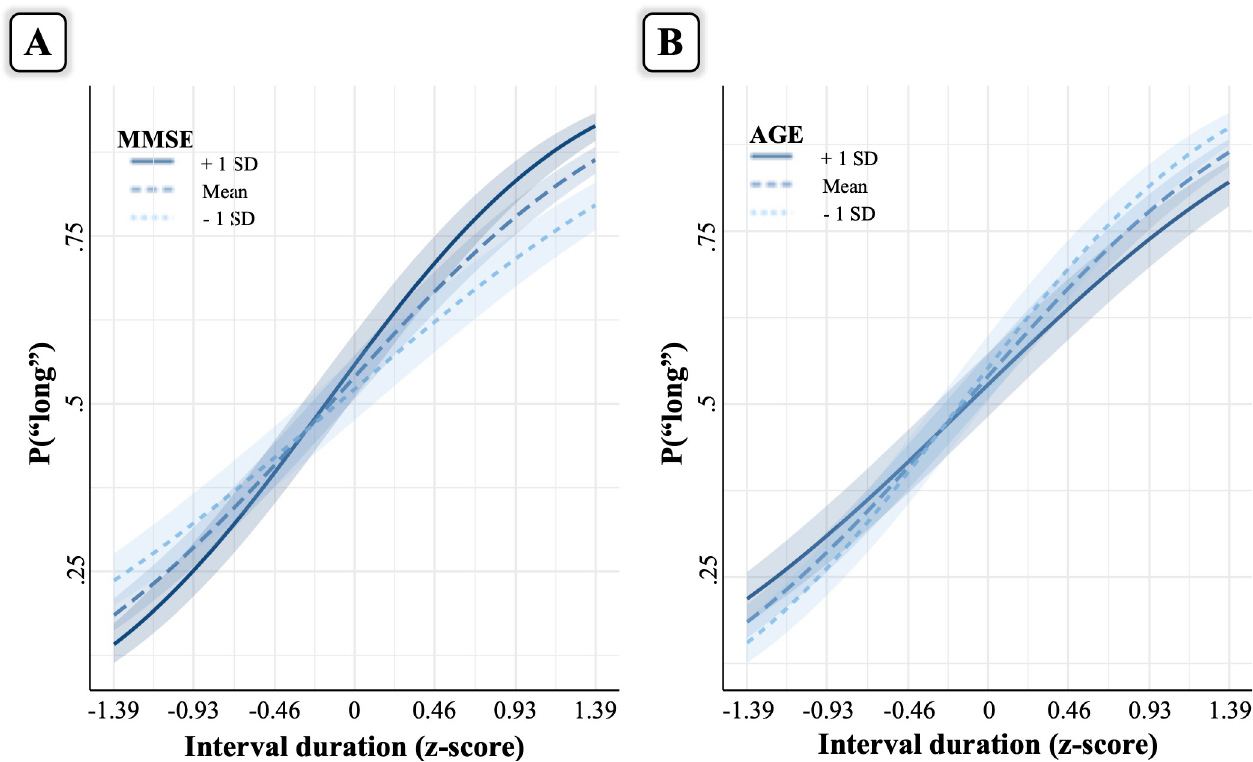
Fig 3. Interaction effects in the explicit timing task. Panel A depicts the interaction between Interval duration and MMSE, whereas panel B depicts the interaction between Interval duration and Age. The interaction plots were obtained using the "interact_plot" function of the R package interactions, which by default plots the marginal effects of the first continuous predictor (i.e., interval duration) at 1 standard deviation above (+1SD) and below (-1SD) the mean and at the mean itself of the second predictor (i.e., MMSE and Age, respectively). The seven interval durations on the x-axis represent the actual durations used in the task.